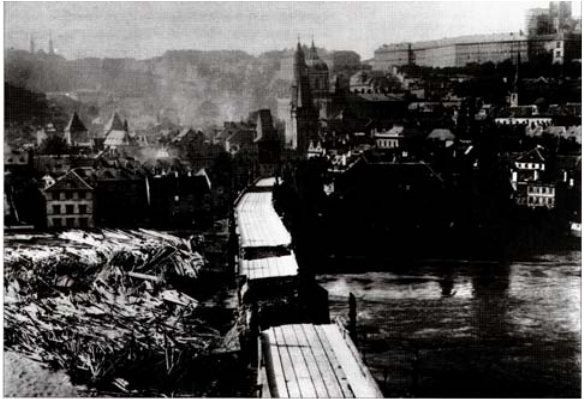
Fig 2. Collapse of 3 bridge vaults and piers of Charles Bridge during the flood of